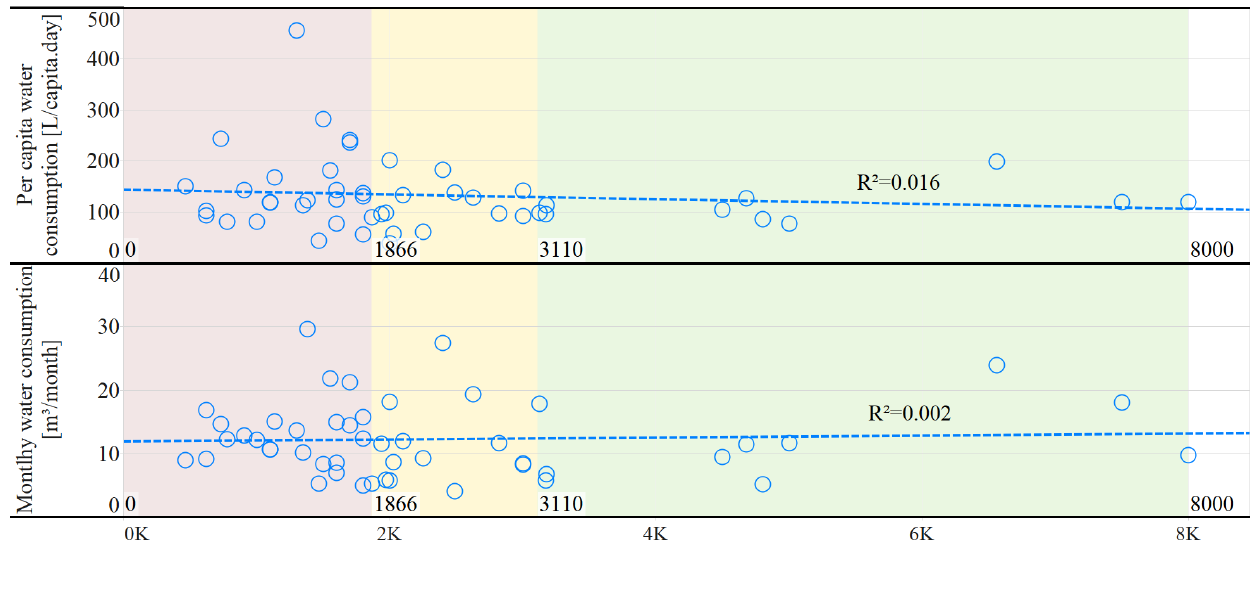
Figure 4. Correlation between the monthly water consumption and per capita water consumption with household income, showing the three intervals of